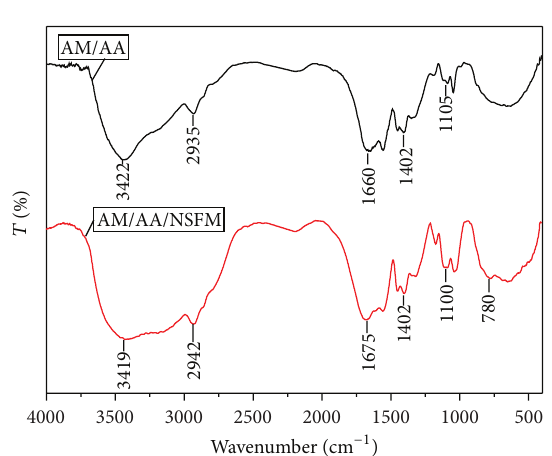
laser light scattering